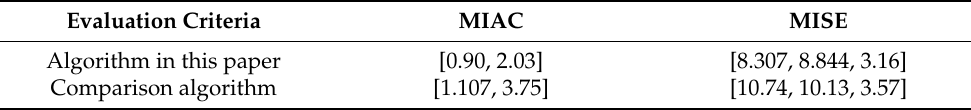
Table 1. Quantitative analysis of the controller’s control effect. Evaluation